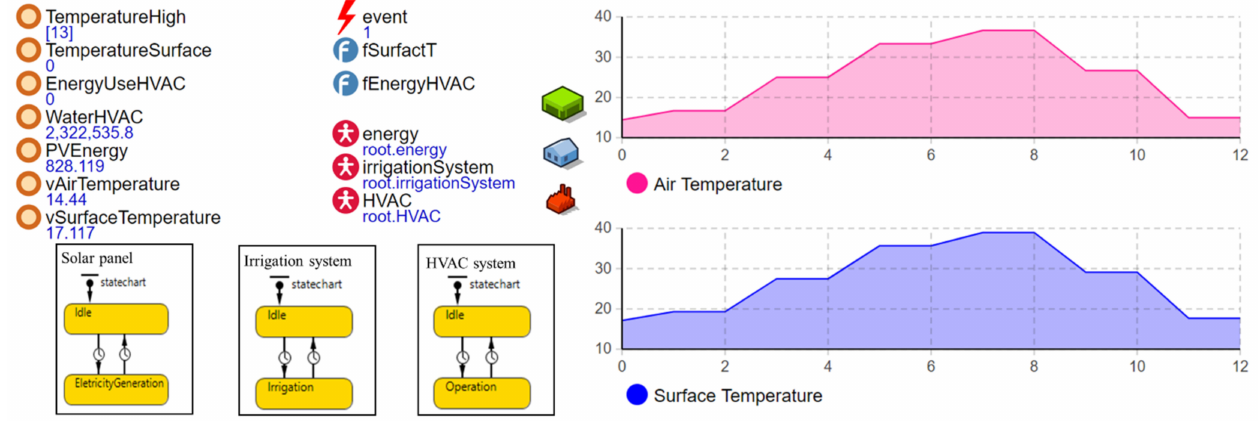
Figure 4. Overview of the proposed simulation